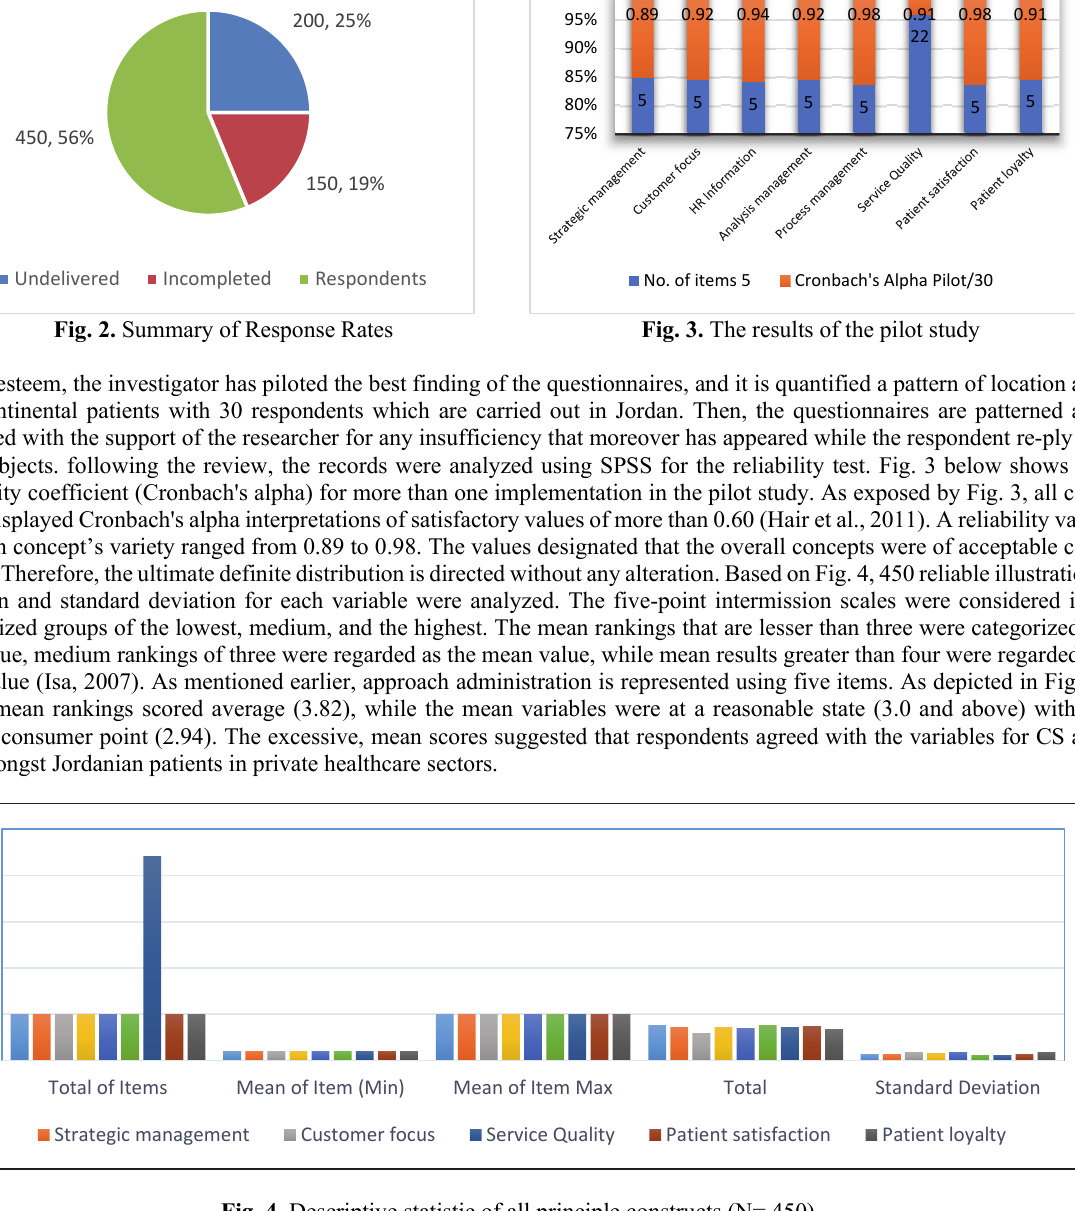
Fig. 4. Descriptive statistic of all principle constructs (N=